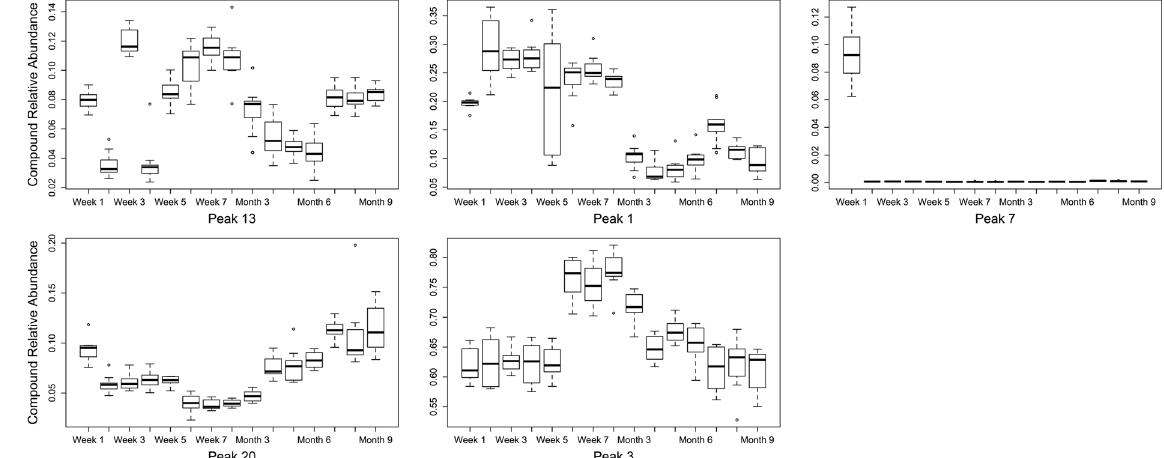
Figure 3. The top five hydrocarbon compounds identified that contributed to the most variation in Lucilia sericata puparial case age (1 week to 9 months): 9,17-diMethylnonacosane (Peak 13), Pentacosane (Peak 1), Nonacosene (Peak 7), Tritriacontane (Peak 20), and Heptacosane (Peak 3). The solid black line across the color box represents the median value, while a hollow circle indicates an outlier value.